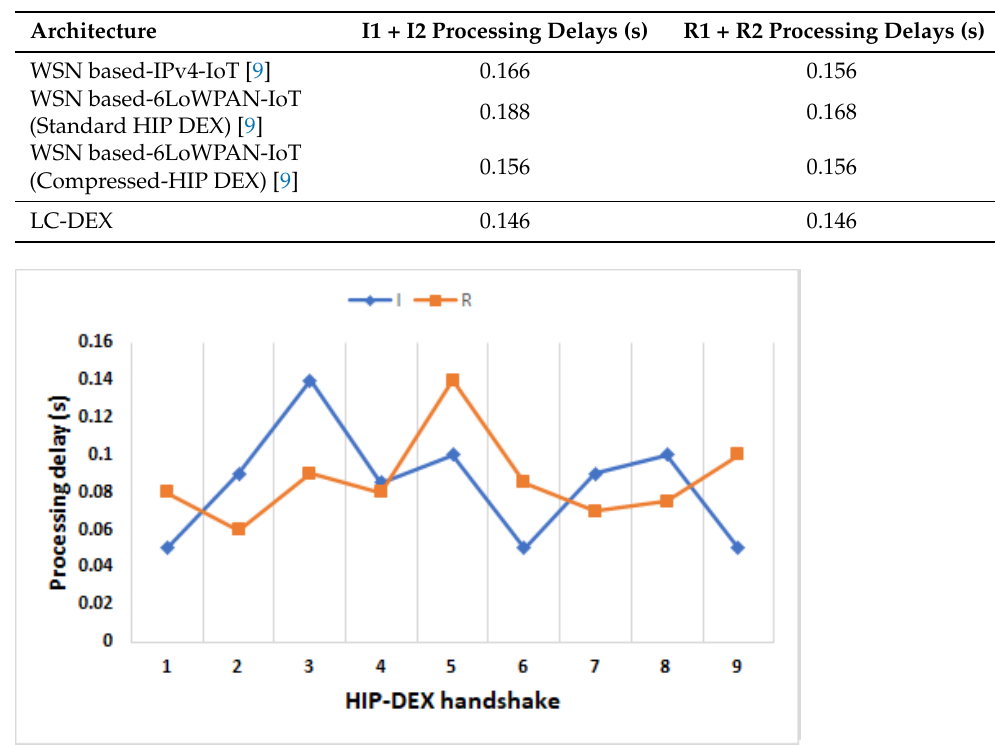
Table 9. Processing delays of handshake’s packets before and after proposed compression.